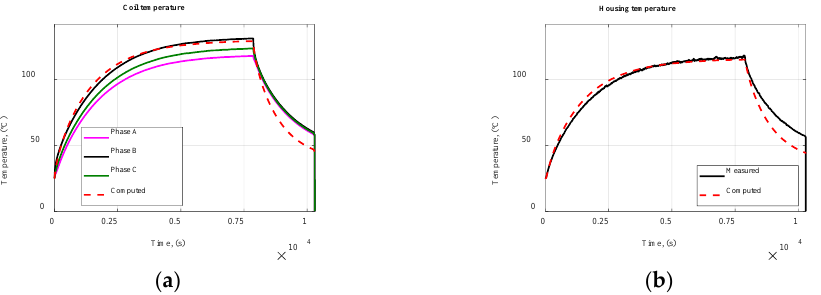
Figure 9. Measured and computed temperatures in the three phases ( a ) and in the housing ( b ) for the long-time pulse test in configuration B.